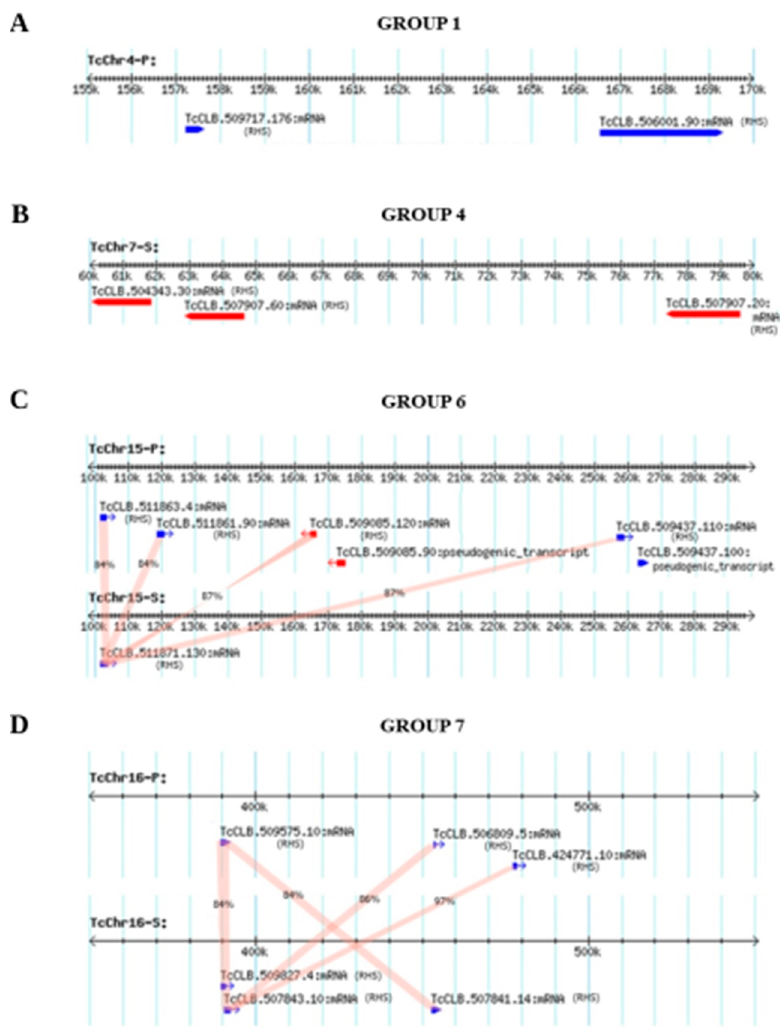
Figure 3. Gene duplication events in the RHS sequences of clone CLB. The figure shows the physical map of the chromosome regions involved in the recombination event. For clarity, only RHS sequences are shown. The direction of transcription is indicated by blue (sense) and red (anti-sense) arrows. ( A , B ) Groups 1 and 4: duplication of RHS genes by unequal crossing-over with loss of tandem counterparts in one of the haplotypes (TcCh4-S and TcChr7-P). ( C ) Group 6: duplication of the RHS genes by unequal crossing-over with the conservation of one of the RHS counterparts in the TcChr15-S haplotype. ( D ) Group 7: duplication followed by genetic conversion between paralogous genes located in the TcChr16-P and TcChr16-S haplotypes (interlocus nonallelic gene conversion). The identity between homologous RHS proteins of the P and S haplotypes is indicated in the figure. The identity between paralogous RHS proteins ranged from 93 to 100%. The physical maps showing the position of RHS sequences were downloaded from the public genome database TriTrypDB [41].